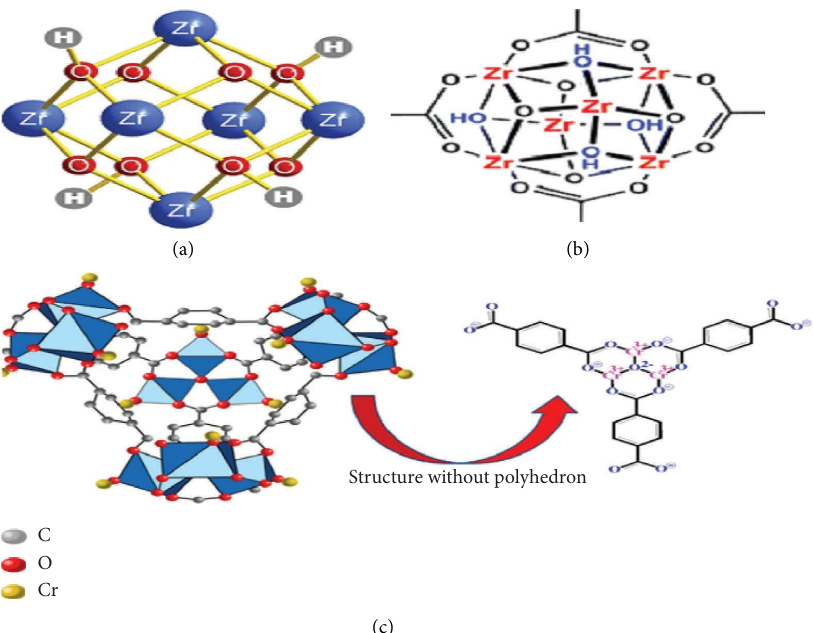
Figure 2: Common Zr and Cr based MOFs structures [16]. (a) UiO-66. (b) UiO-67. (c) MIL-101